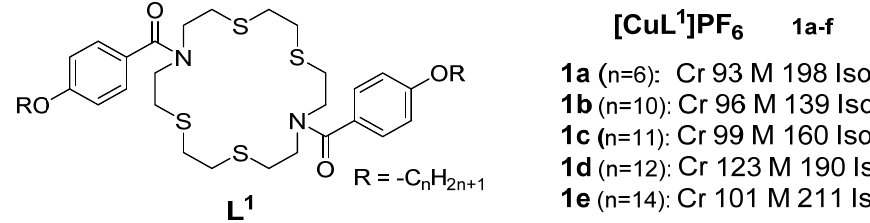
Figure 1. Copper(I) complexes from azamacrocycle derivatives. Transition temperatures are in °C